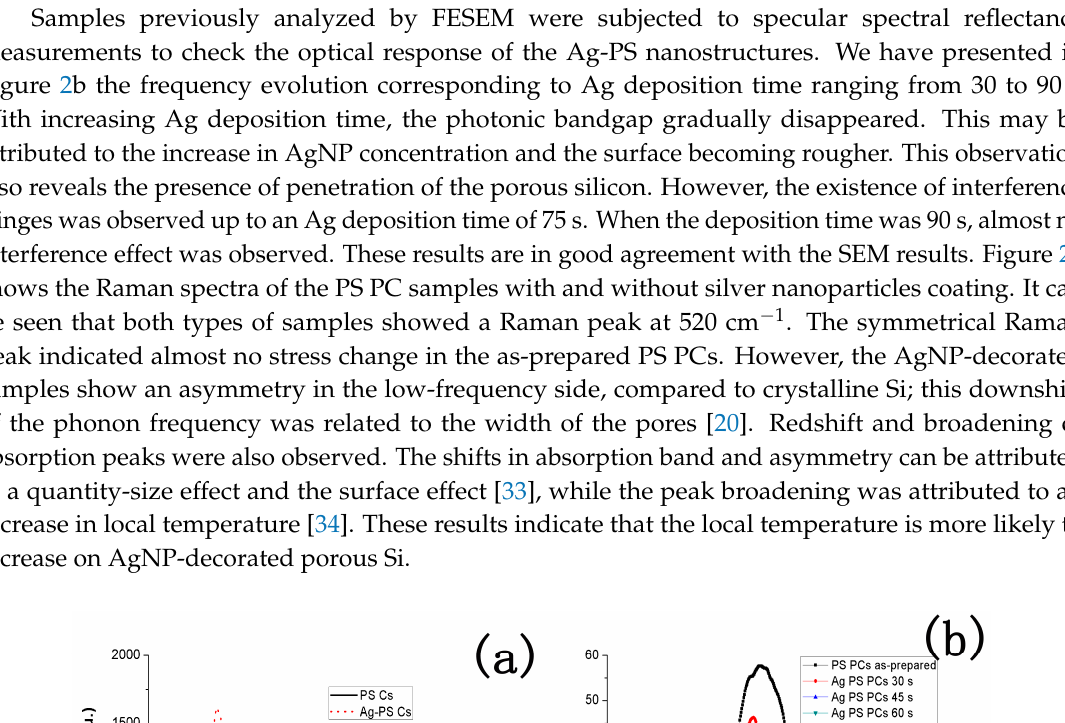
Table 1. Assignment of vibrational modes in SERS Spectra of Rhodamine 6G dye (R6G) and picric acid (PA).